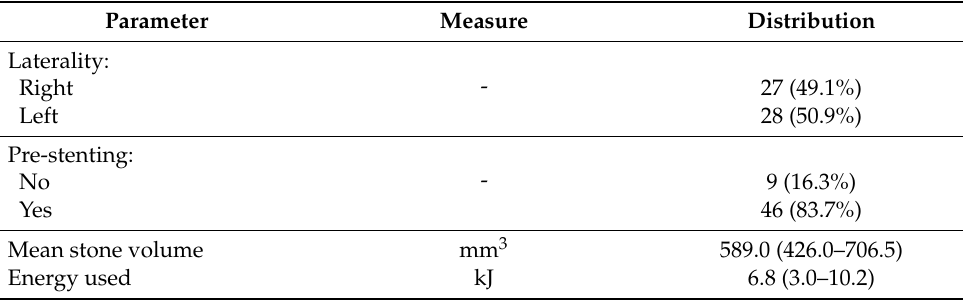
Table 2. Characteristics of clinical data without repeated measures, N obs =